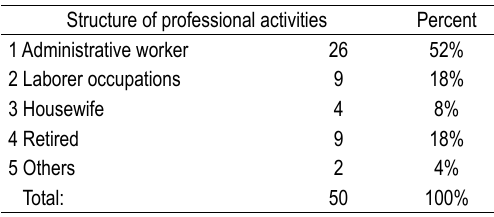
Table 4. Structure of professional